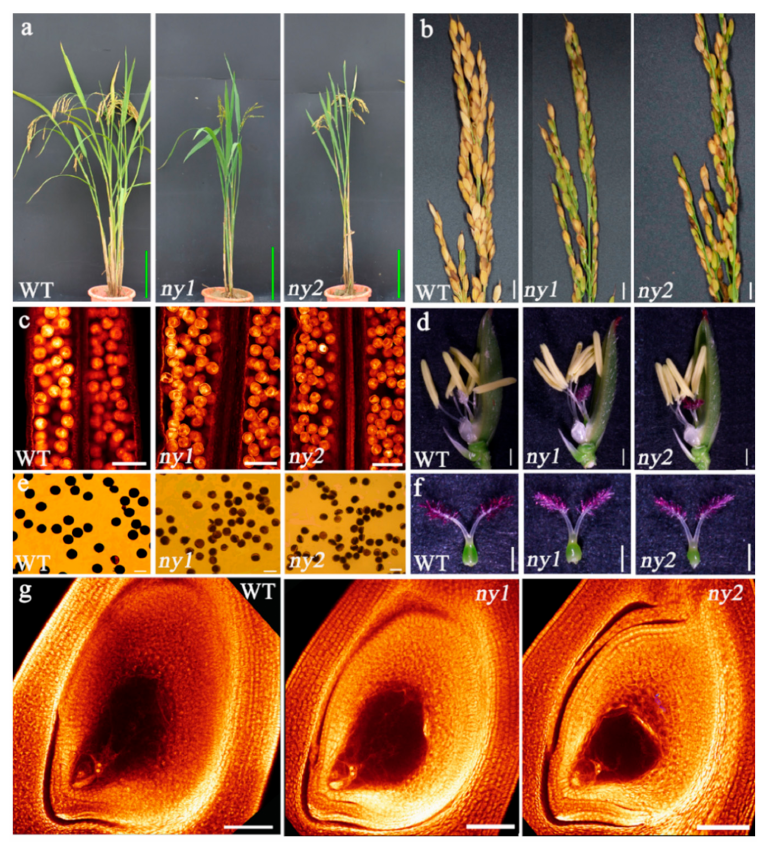
Figure 5. Phenotypic characterization of wild type (WT), ny1 and ny2 mutant lines. ( a ) Plant morphol- ogy of the WT, ny1 and ny2 mutants at mature stage. Bars = 20 cm. ( b ) Mature panicles. Bars = 1 cm. ( c ) Pollen grains observed by whole-mount eosin B-staining confocal laser scanning microscopy (WE-CLSM). Bars = 100 µ m. ( d ) Florets. Bars = 1 mm. ( e ) I 2 -KI staining of pollen grains. Bars = 50 µ m. ( f ) Pistils. Bars = 1 mm. ( g ) Mature embryo sac. Bars = 100 µ